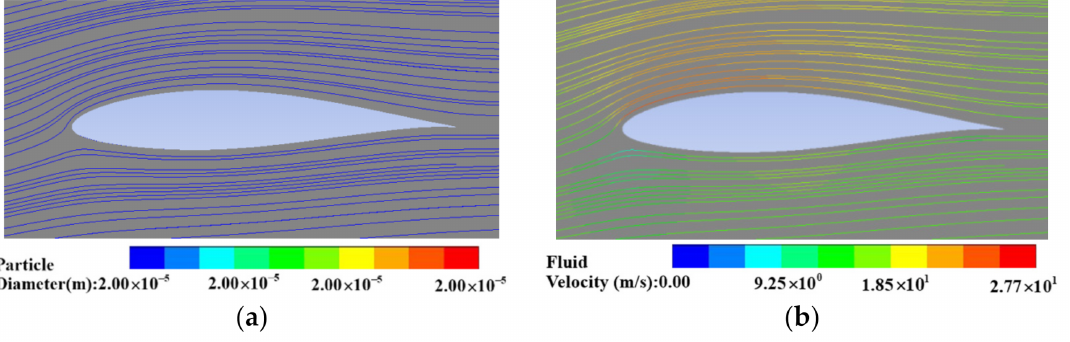
Figure 12. The particle trajectories and the fluid streamlines when the particle diameter is 20 µ m: ( a ) the particle trajectories; ( b ) the fluid